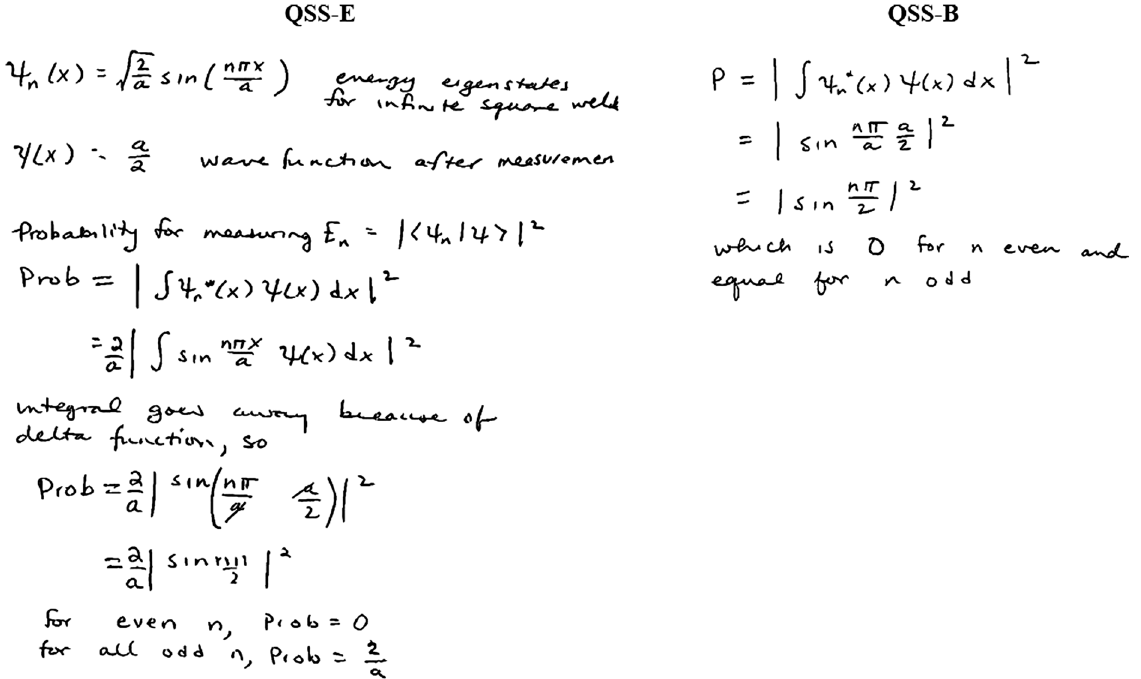
FIG. 4. For the quantum mechanics physics problem, a quantum mechanics student solution that is elaborated (QSS-E), and a quantum mechanics student solution that is brief